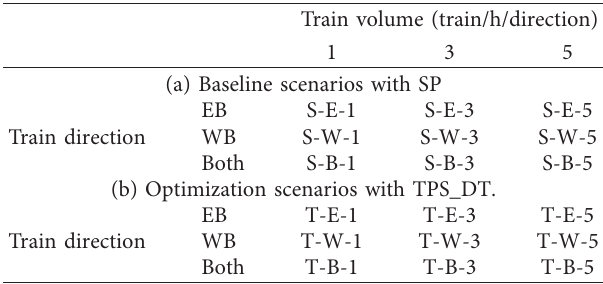
Table 2: Simulation